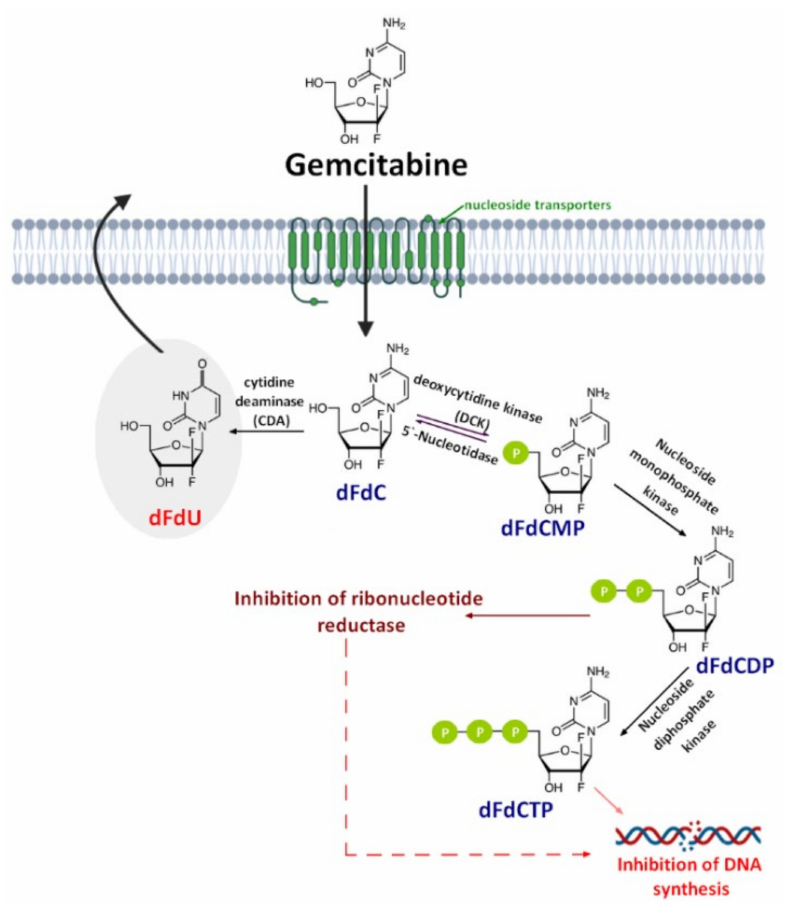
Figure 1. A schematic of gemcitabine (dFdC) cellular uptake, mechanism of action, and metabolism. dFdCMP: Gemcitabine monophosphate; dFdCDP: Gemcitabine diphosphate; dFdCTP: Gemcitabine triphosphate; and dFdU: 2 (cid:48) ,2 (cid:48) -difluoro-2 (cid:48)